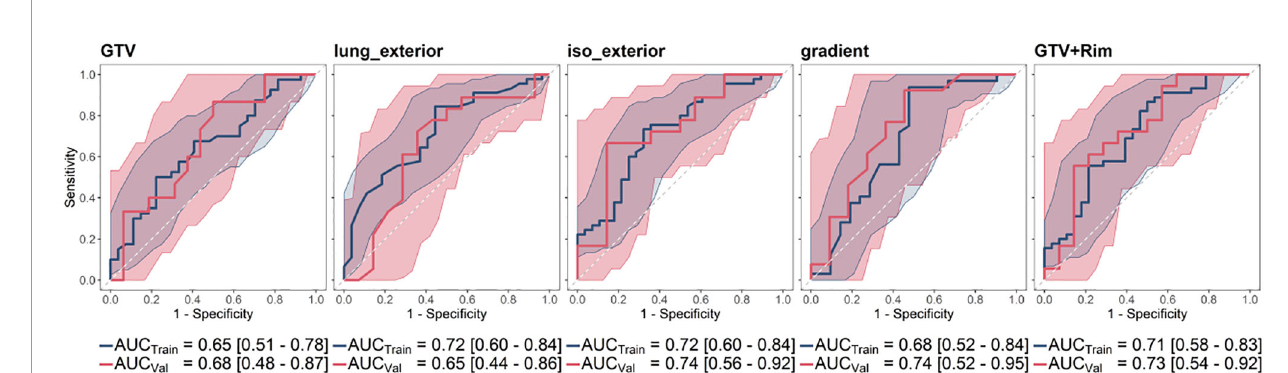
FIGURE 3 | Receiver operating characteristic curve (ROC) curves and corresponding mean AUC [95% con fi dence interval] of the analyzed ROIs shown for training (blue) and validation cohort (red). The radiomic models based on GTV and lung_exterior could not be successfully validated in the validation cohort. Iso_exterior, gradient and GTV+Rim models had good performances in